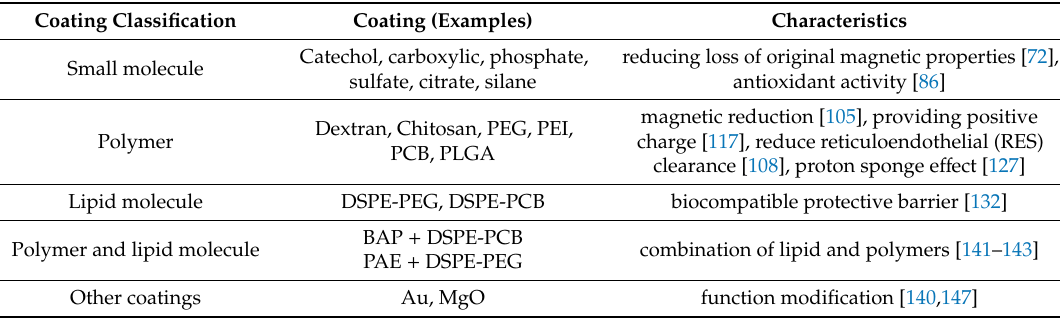
Table 1. Summary of di ff erent coatings.